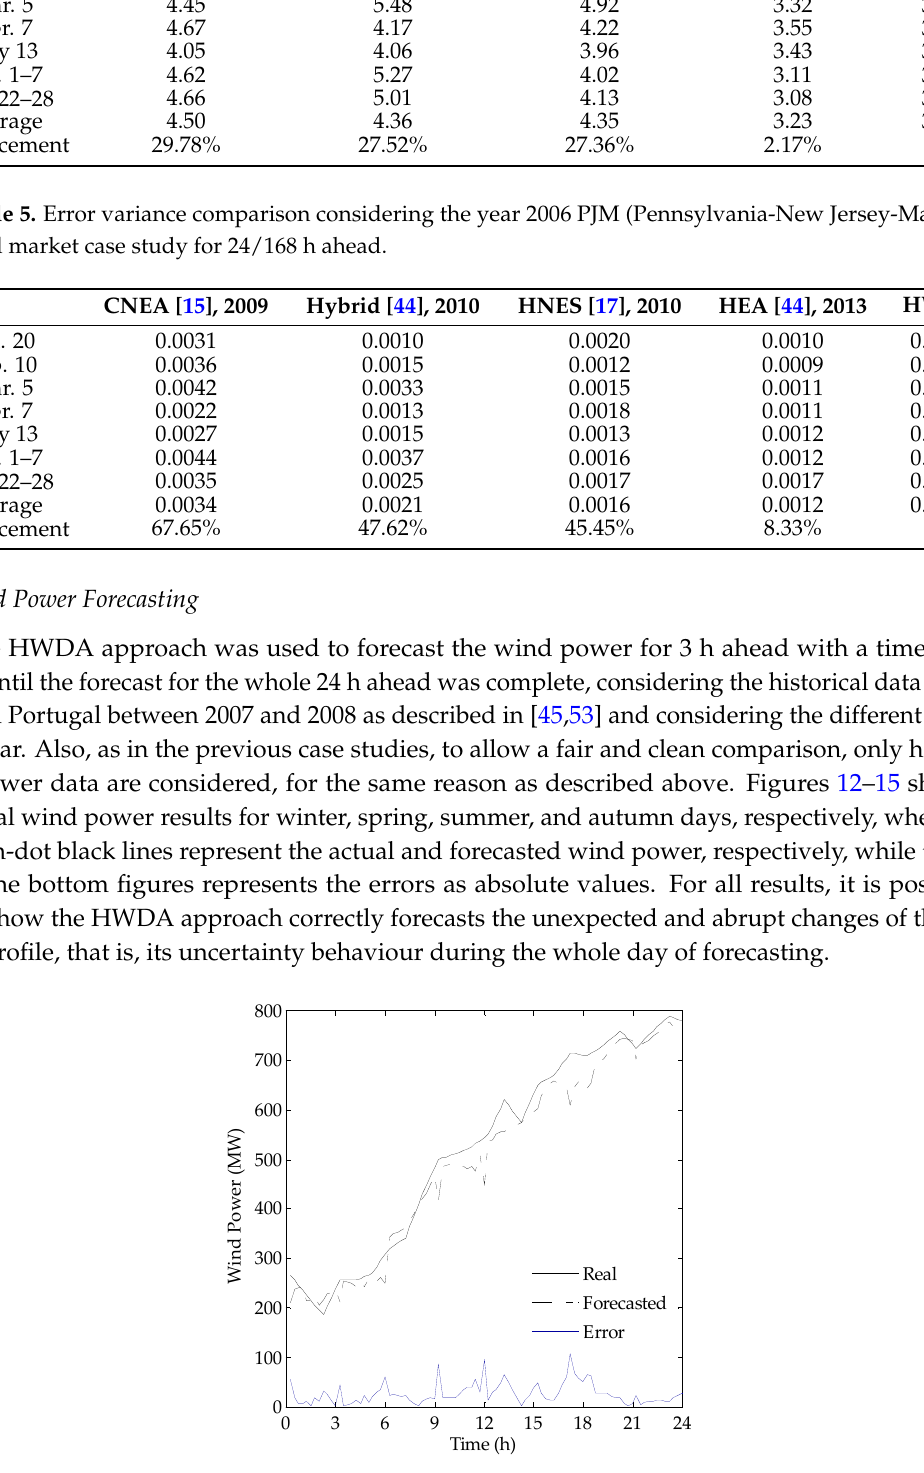
Figure 12. Real and forecasted wind power results (15 min intervals) for the Winter day.